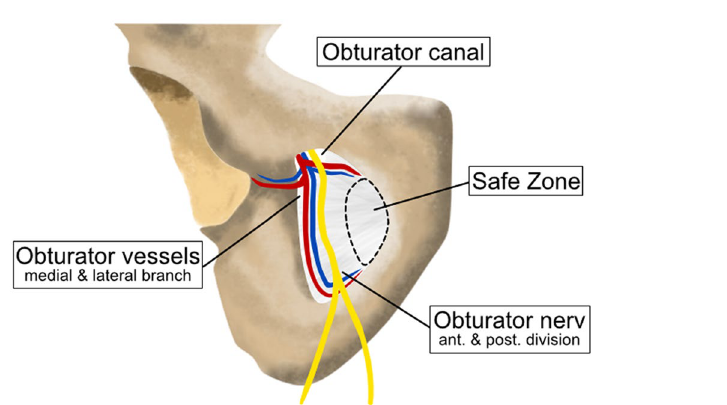
Figure 6. Anatomical landmarks. ( A ) Pubic symphysis anteriorly fixed with a trans-obturator cable. ( B ) Dotted line encircles the obturator foramen. The membrane does not seal the whole foramen. The asterisk marks the vessels and the nerve leaving for the obturator canal. ( C ) Obturator foramen from a more lateral perspective. Note the distance to the cable system. ( D ) View from the cranial pubic rim of the pubic branch. The bladder is retracted.